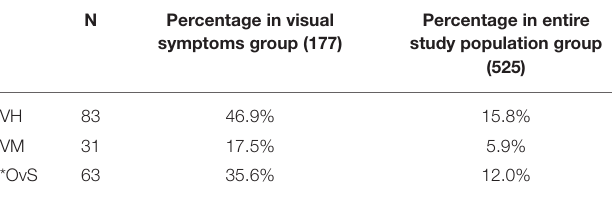
TABLE 2 | Percentage of visual complaints in the study population, n =